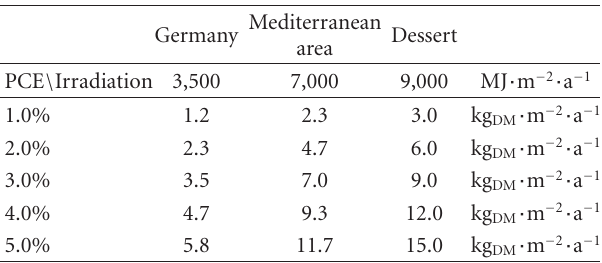
Table 1: Microalgae biomass yield per square meter of surface area as function of PCE for three di ff erent solar irradiations assuming a lower heating value of 30 MJ · kg − 1 dry